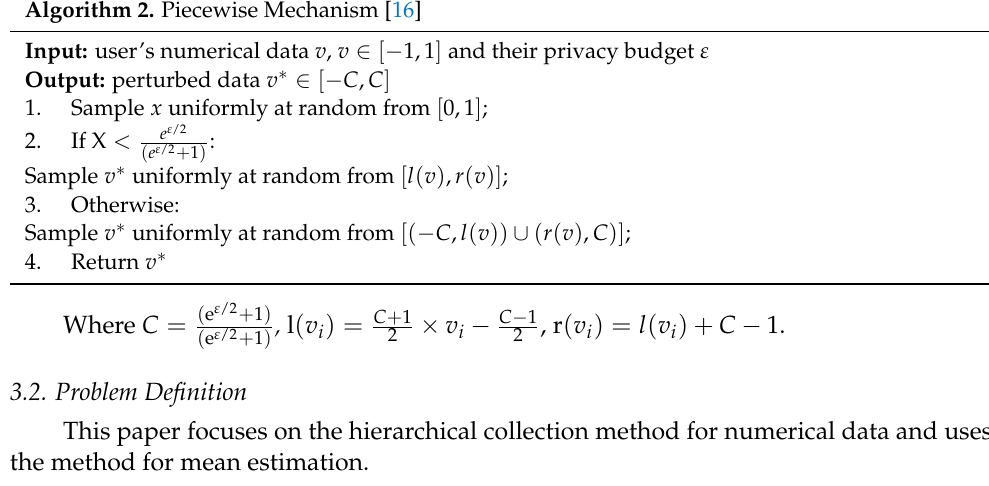
Algorithm 2. Piecewise Mechanism